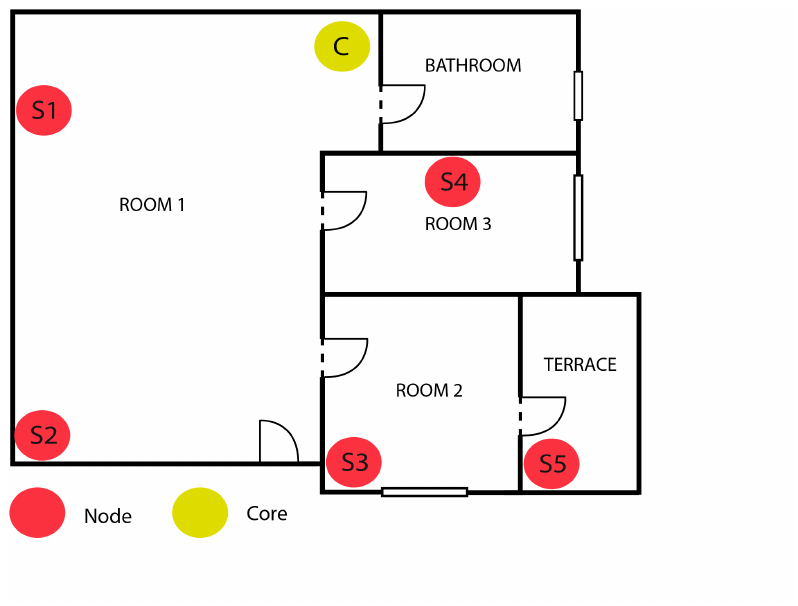
Figure 6. Example of WASN deployment in an indoor